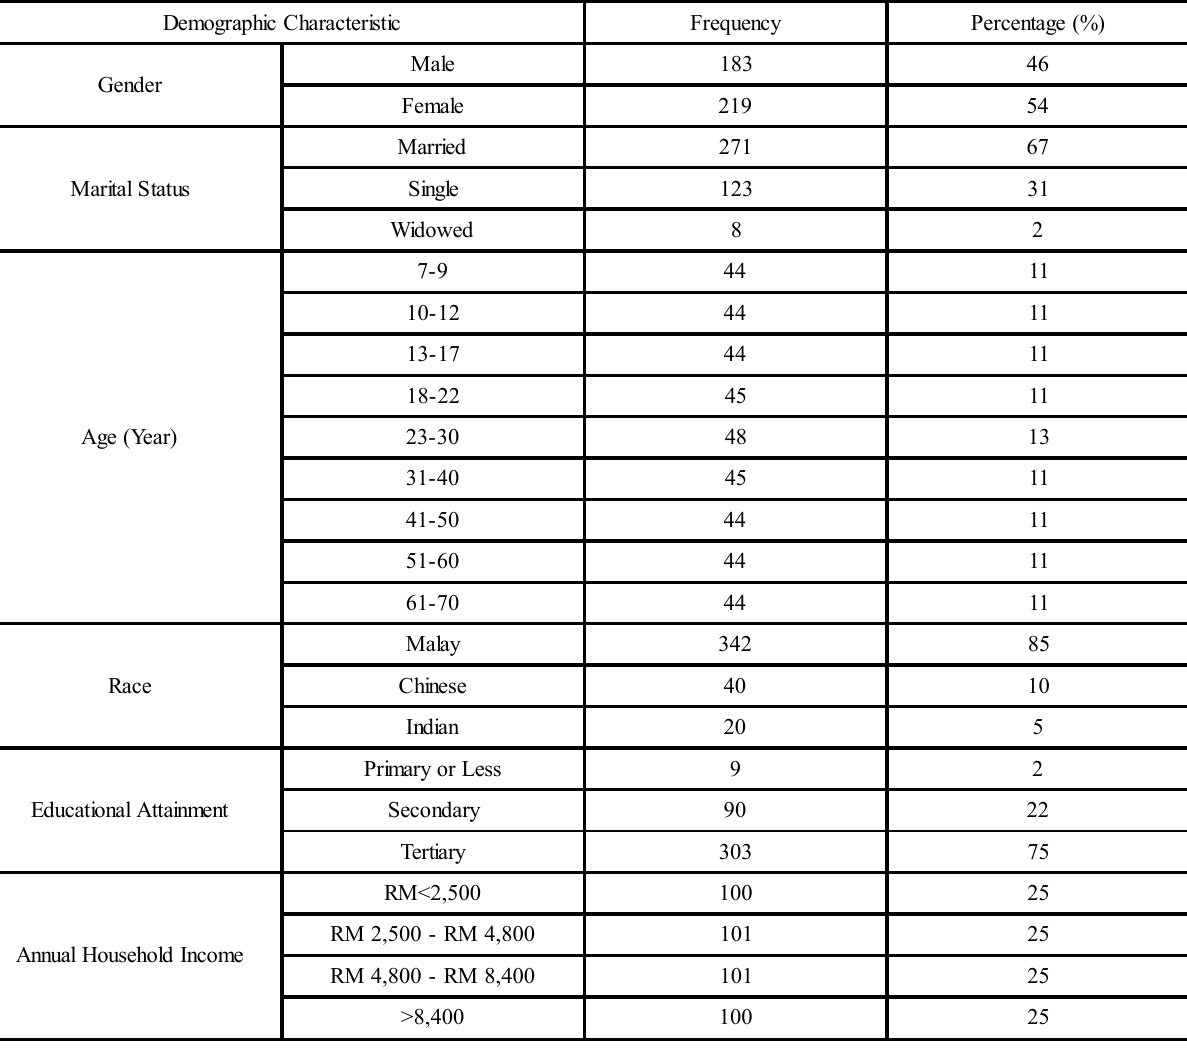
TABLE 2. RESIDENTS‘ DEMOGRAPHIC CHARACTERISTIC OF THE SAMPLE